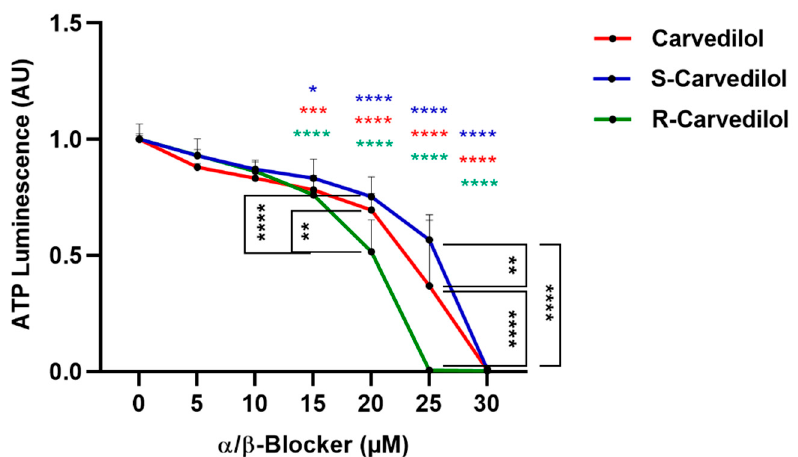
Figure 2. Comparison of cytotoxic effects of carvedilol, S- and R-carvedilol on 3D tumor spheroid viability. Mel270 spheroids were treated with either carvedilol or enantiomers S-carvedilol ( α /ß- blocker) and R-carvedilol ( α -blocker) at the indicated concentrations. After 7 days of incubation, spheroid viability was assayed with an ATP luminescence assay. The ATP luminescence of the treated spheroids was normalized to the ATP luminescence of the control spheroids (0 µ M ß-blocker) and is given in arbitrary units (AU). Representative results from 3 independent experiments are shown. The means ± SD of n = 8 spheroids for each condition are shown. Statistical analysis by two-way ANOVA and Tukey’s multiple comparisons test are shown with significance levels indicated at * p < 0.05, ** p < 0.01, *** p < 0.001, and **** p < 0.0001. Significance levels of the treated spheroids in relation to the control spheroids (0 µM ß-blocker) are displayed in color.